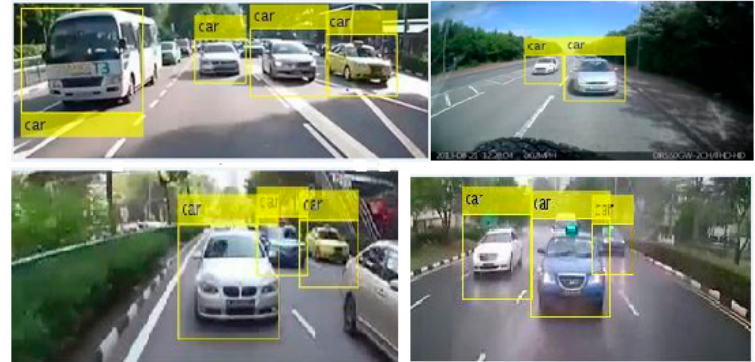
Figure 15. Detected vehicles.